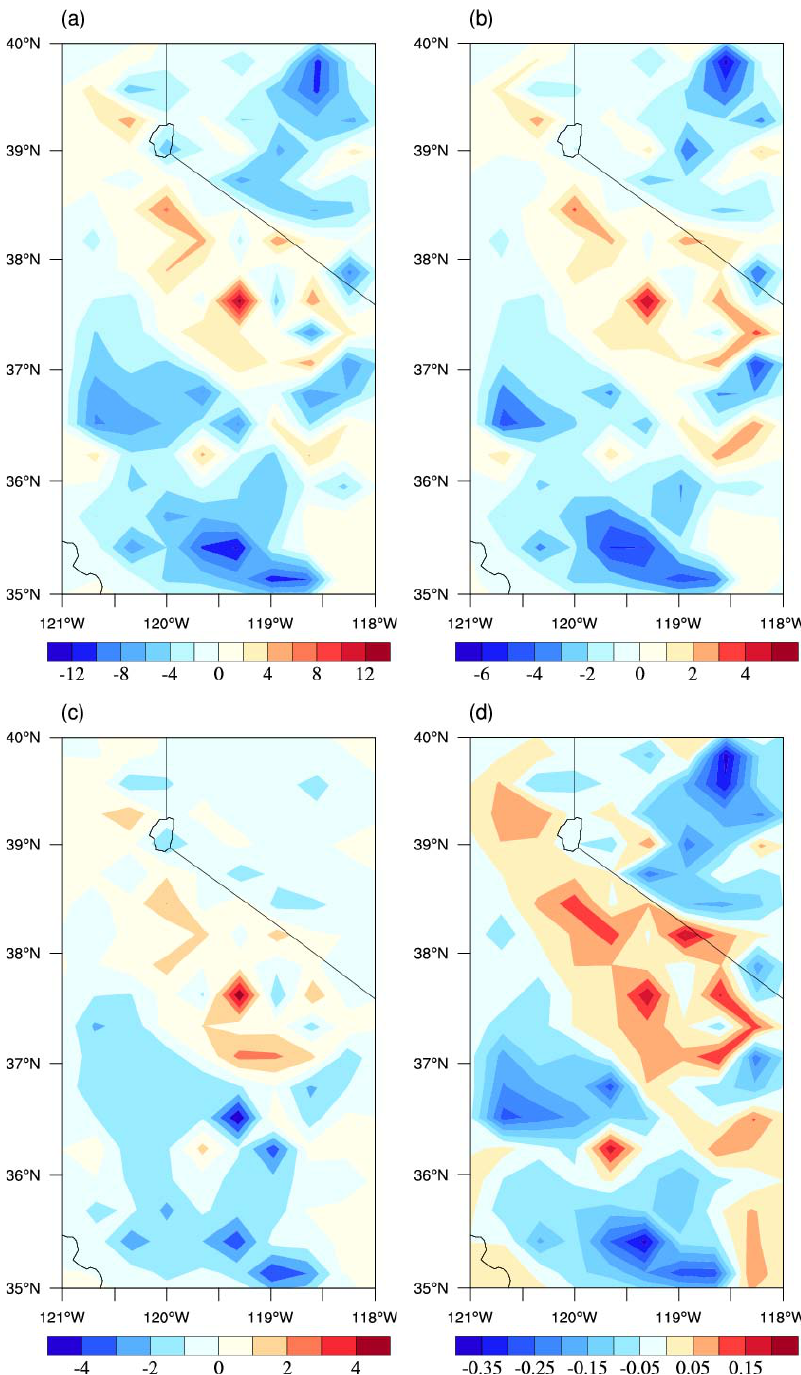
Fig. 6. Spatial distribution of the day-averaged deviations of (a) surface solar flux (Wm − 2 ), (b) sensible heat flux (Wm − 2 ), (c) latent heat flux (Wm − 2 ), and (d) surface skin temperature (K) over the Sierra-Nevada area on 29 March 2007.